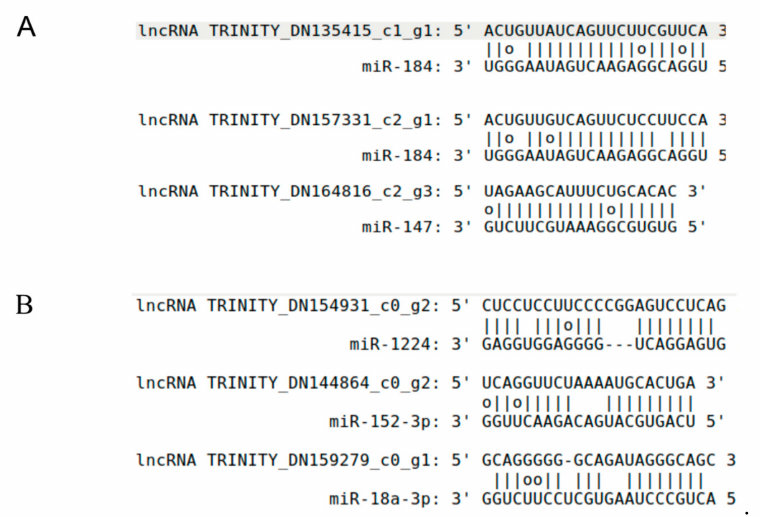
Figure 4. The predicted alignments between miRNAs and lncRNAs. ( A ) LncRNAs predicted as putative miRNA targets. The rules of miRNA targets were showed as follows: at most, one mismatch or indel was allowed between the 9th and 12th positions of the 5 (cid:48) end of miRNA sequence, the total number of bulges or mismatches in the other regions was not allowed to exceed 4 nt, and no continuous mismatches were allowed. In this figure, miR-184 has perfect matches with the three lncRNA targets between 9th and 12th from miRNA 5 (cid:48) end, and has 0~2 discontinuous mismatches in other regions. G-U pairs were not considered as a mismatch for RNA molecular. ( B ) LncRNAs are predicted as putative miRNA target mimics. The rules of miRNA target mimics were showed as follows: the number of mismatches or indels should be larger than 1 and less than 6 between 9th and 12th positions of the 5 (cid:48) end of miRNA sequence, perfect nucleotide pairing was required between the 2nd and 8th positions of the 5 (cid:48) end of miRNA sequences, and the number of mismatches and indels should be no more than 4 nt in other regions. For the miRNA miR-1224, miR-152-3p and miR-18a-3p, all of them have 2~3 mismatches or indels between 9th and 12th from miRNA 5 (cid:48) end, perfect pairing between the 2nd and 8th positions of the 5 (cid:48) end of miRNA, and 2~3 nt mismatches and indels in other